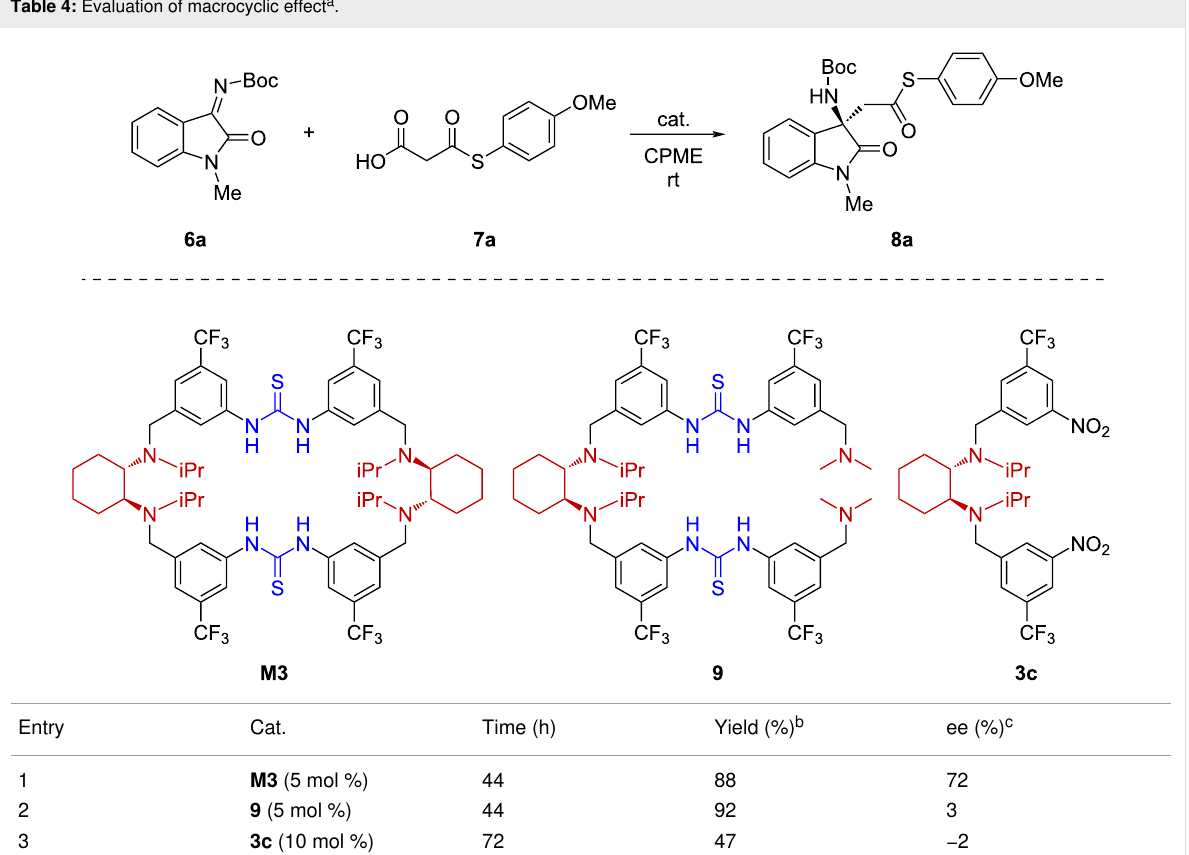
Table 4: Evaluation of macrocyclic effect a